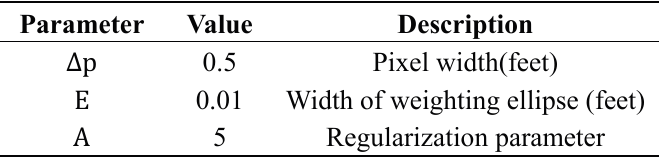
Table 3. The parameters of